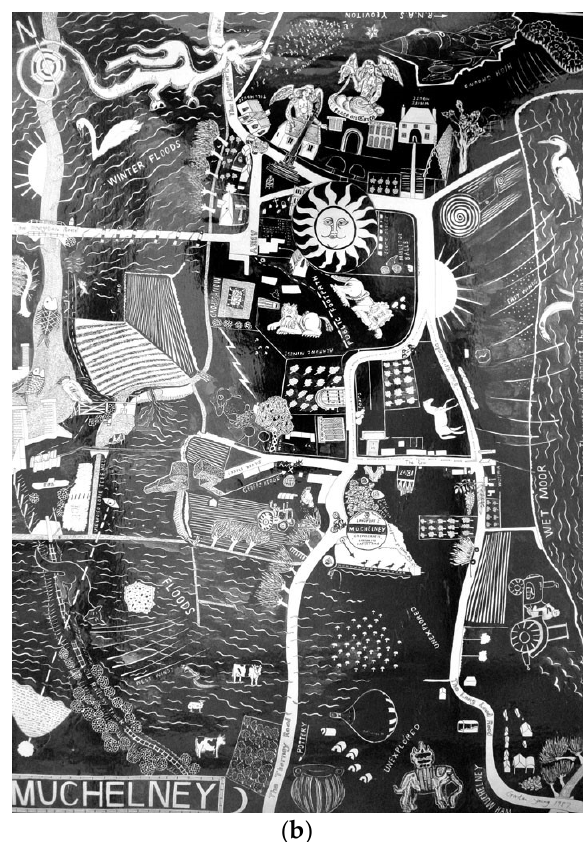
Figure 1. ( a ) Town of Muchelney (UK): codified image of territory. Image source: Google Map; ( b ) One of Muchelney’s Parish Maps. Image source: